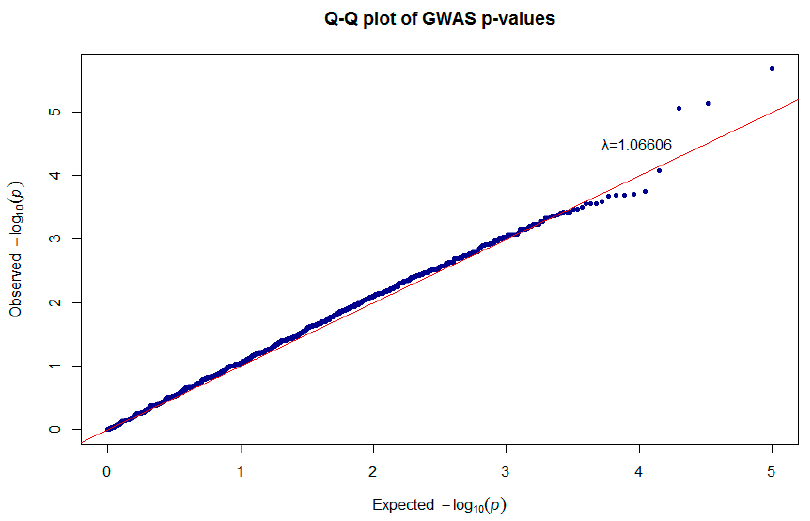
Figure 3. Quantile–quantile plot of genome-wide association study (GWAS) shown in the Manhattan